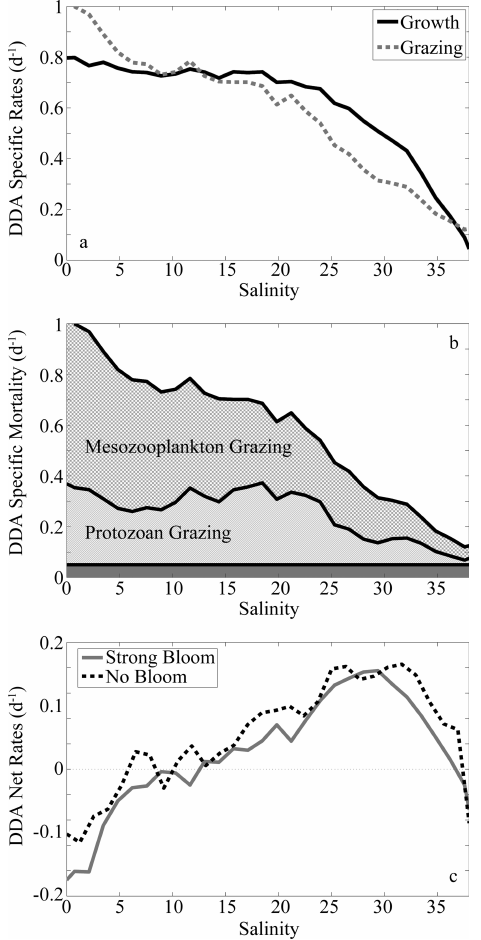
Figure 7. DDA growth and grazing rates along synthetic La- grangian float trajectories. Panel a shows specific growth (solid black line) and mortality (gray dashed line) rates of DDAs along strong bloom float trajectories (float trajectories with max DDA biomass > 0.2µmol NL − 1 ) as a function of salinity. Panel b subdi- vides the mortality rates from panel a into the following categories: natural or non-grazing mortality (solid gray bar at bottom), proto- zoan grazing (diagonal gray lines), and mesozooplankton grazing (gray checkerboard). Panel c compares the net growth rates along strong bloom trajectories (solid gray line) to the growth rates along non-bloom trajectories (max DDA <0.085µmol N L − 1 , dashed black